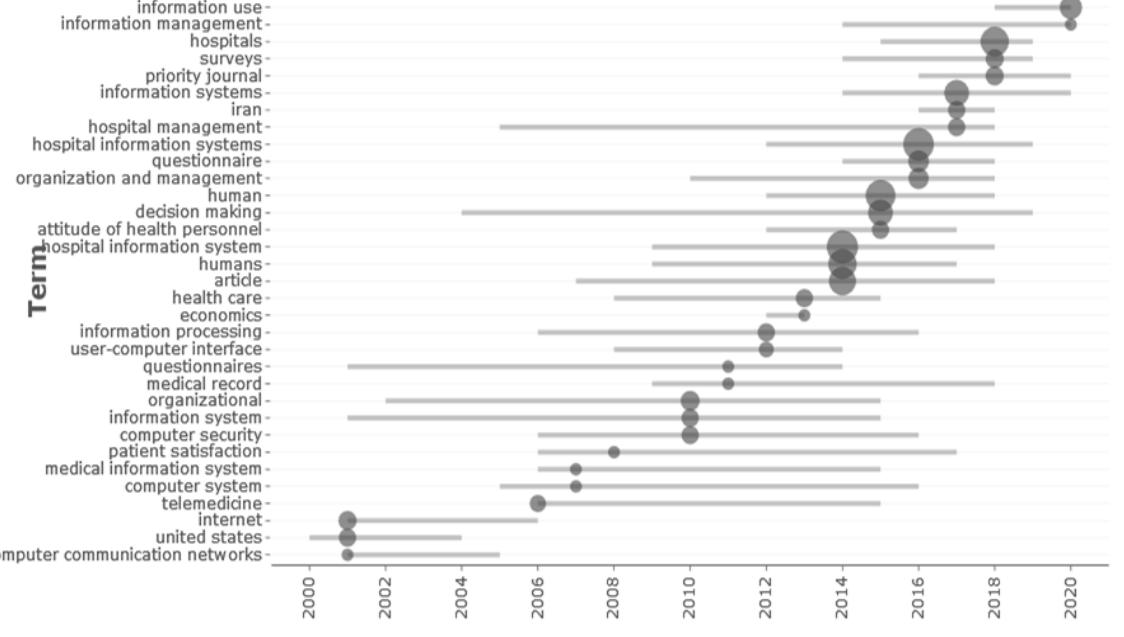
Figure 3. Main journals related to the theme.